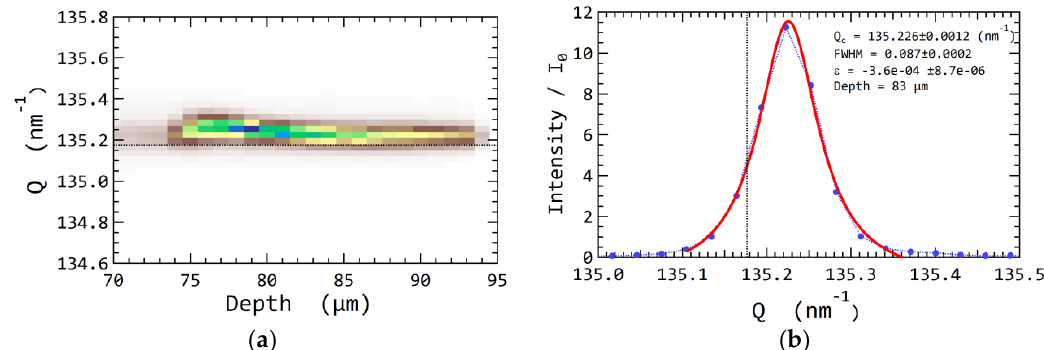
Figure 3. ( a ) The diffraction vector, Q , as a function of depth for one energy wire scan for the 32-5 Laue spot in Figure 2; ( b ) Fitted intensity distribution for the Laue spot for the depth = 83 µm. The center of the fitted Q -distribution, Q C , is used to determine the crystallographic plane spacing, d . The dashed line in ( b ) marks the Q value for d 0 of the (3 2 -5) crystallographic plane. The red line is the fitted result using a Gaussian function.